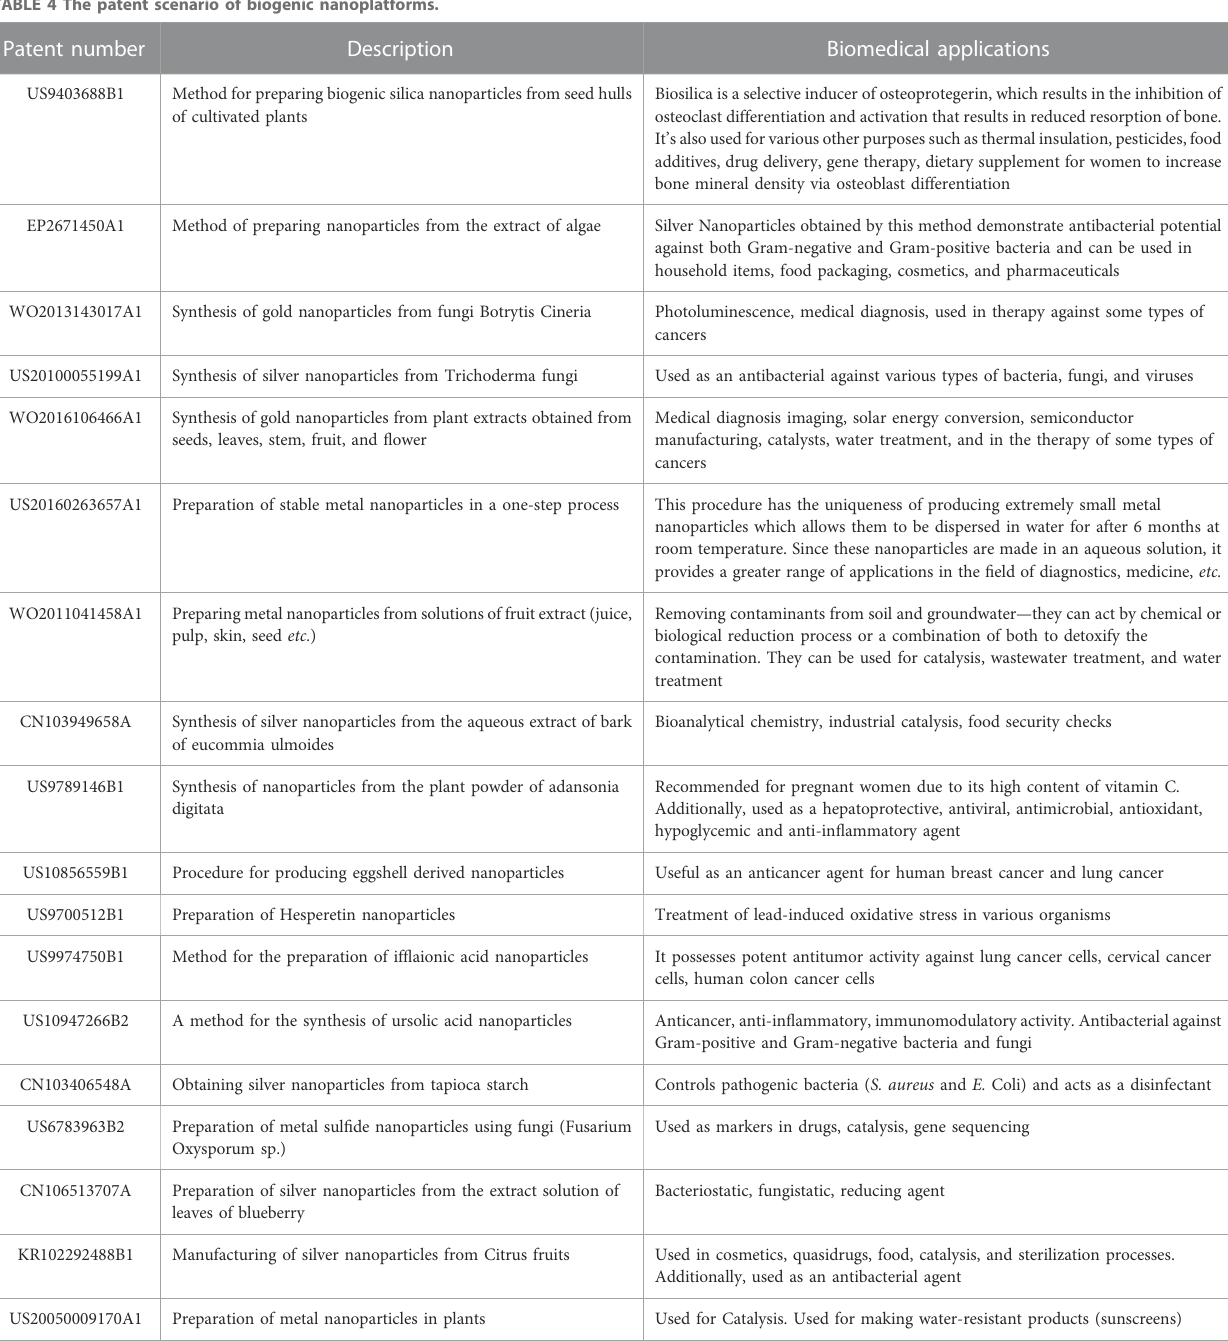
TABLE 4 The patent scenario of biogenic nanoplatforms. Patent number